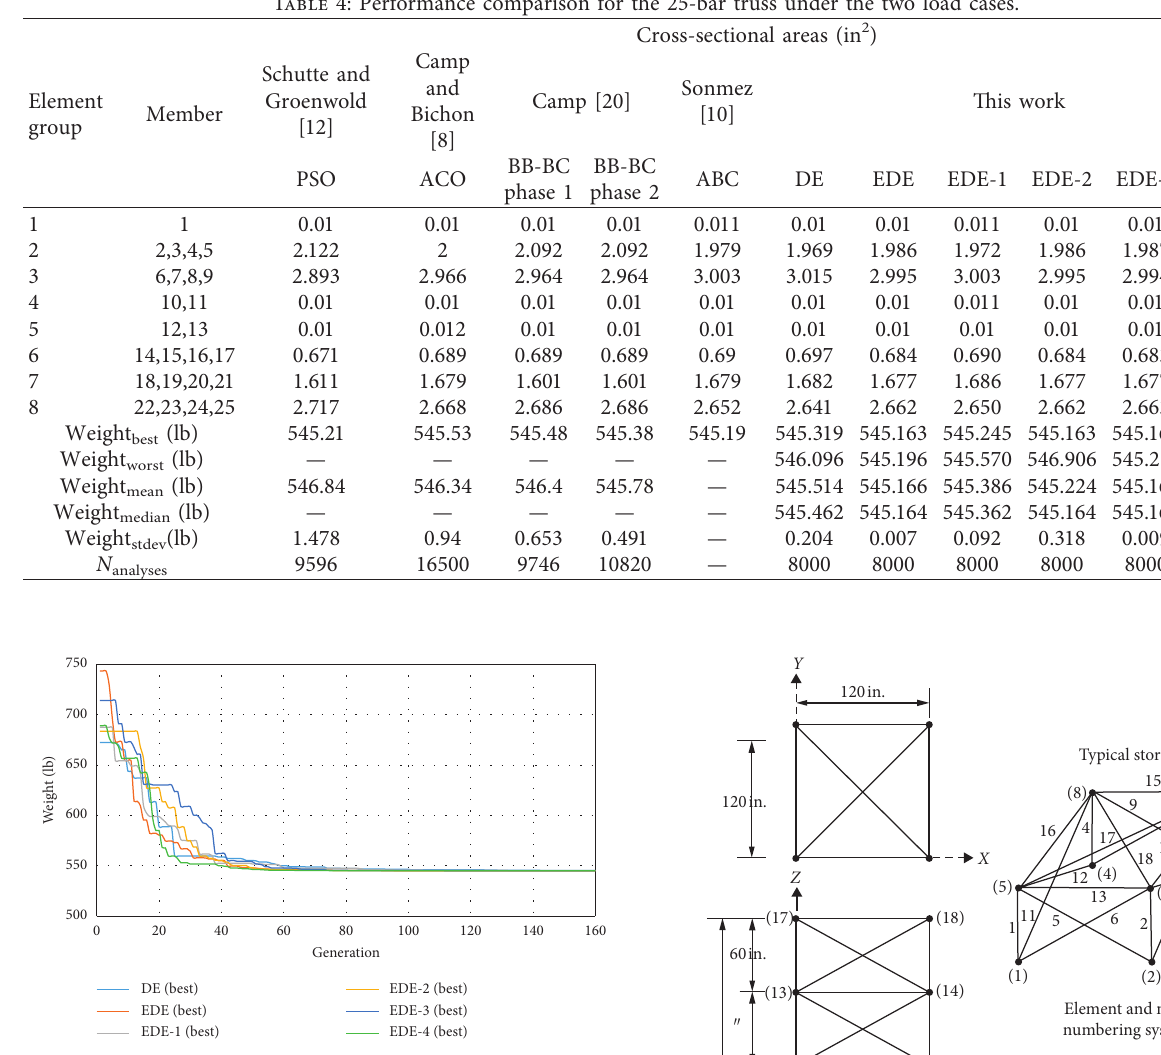
Figure 9: Convergence rates of DE, EDE, EDE-1, EDE-2, EDE-3, and EDE-4 for the 25-bar truss.